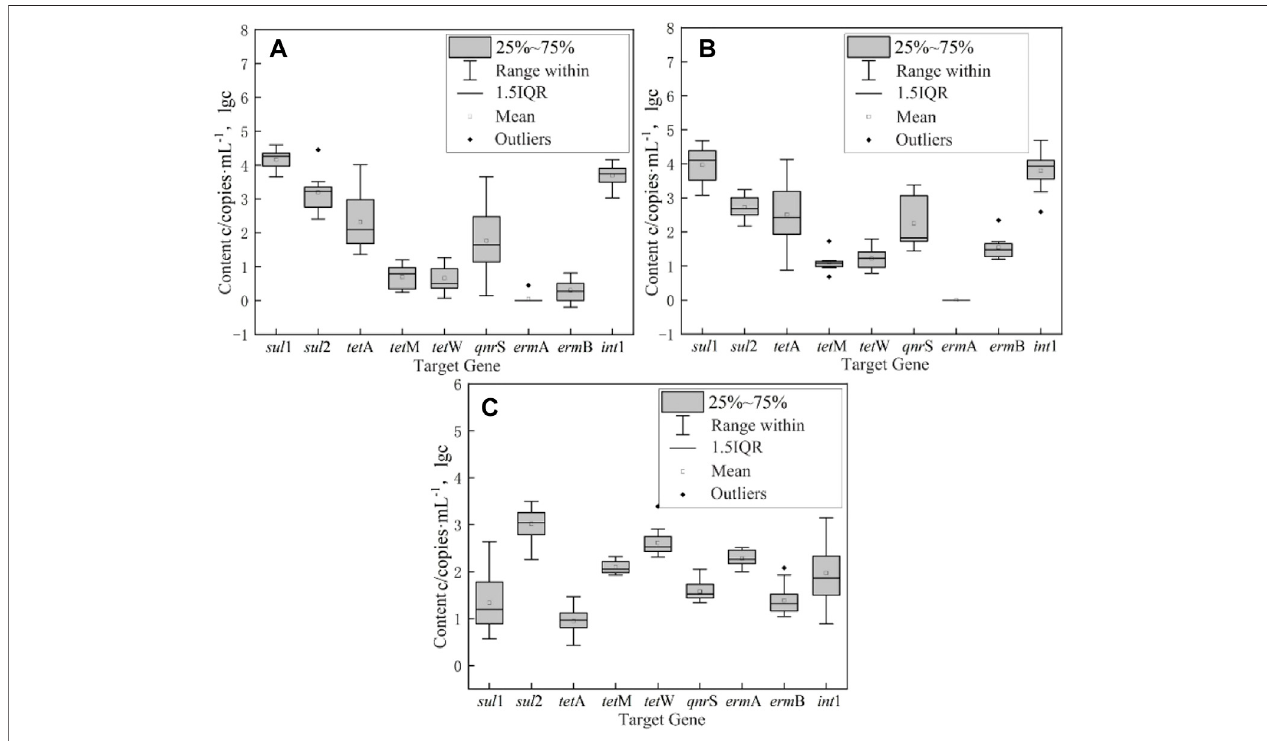
FIGURE 4 | Box-plot of absolute abundance of ARGs and integron int1 in the surface water of East Dongting Lake in spring (A) , summer (B) , and fall (C) .